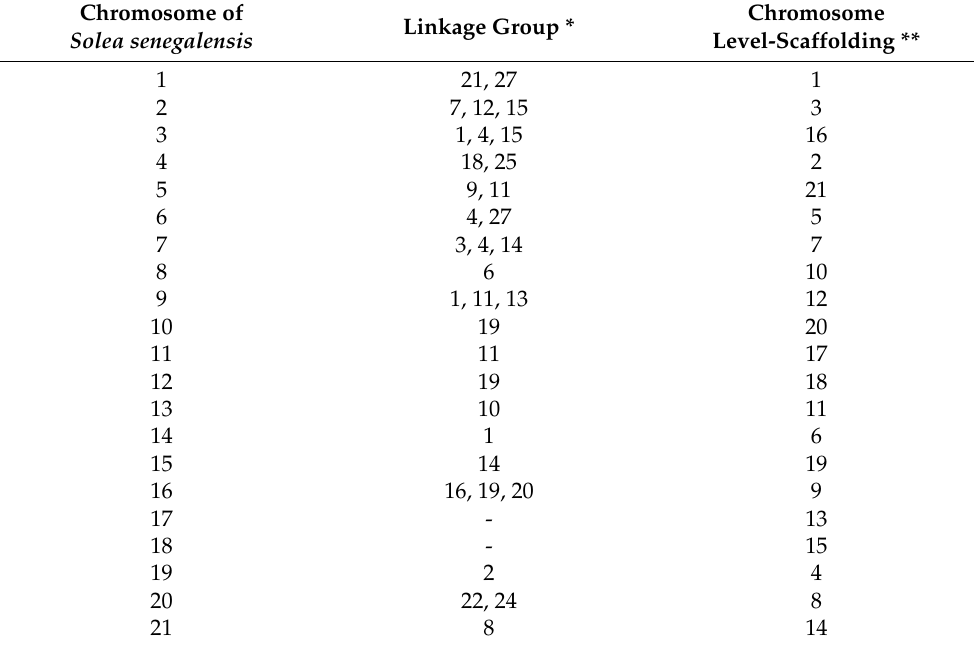
Table 1. Integration of the cytogenetic map of Solea senegalensis with published linkage map and physical map.